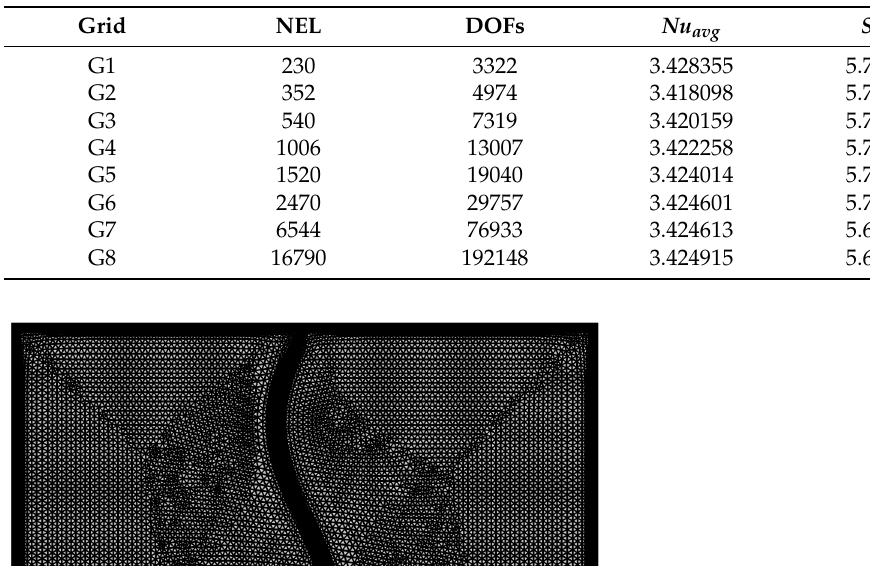
Table 1. Convergence of grid analysis.